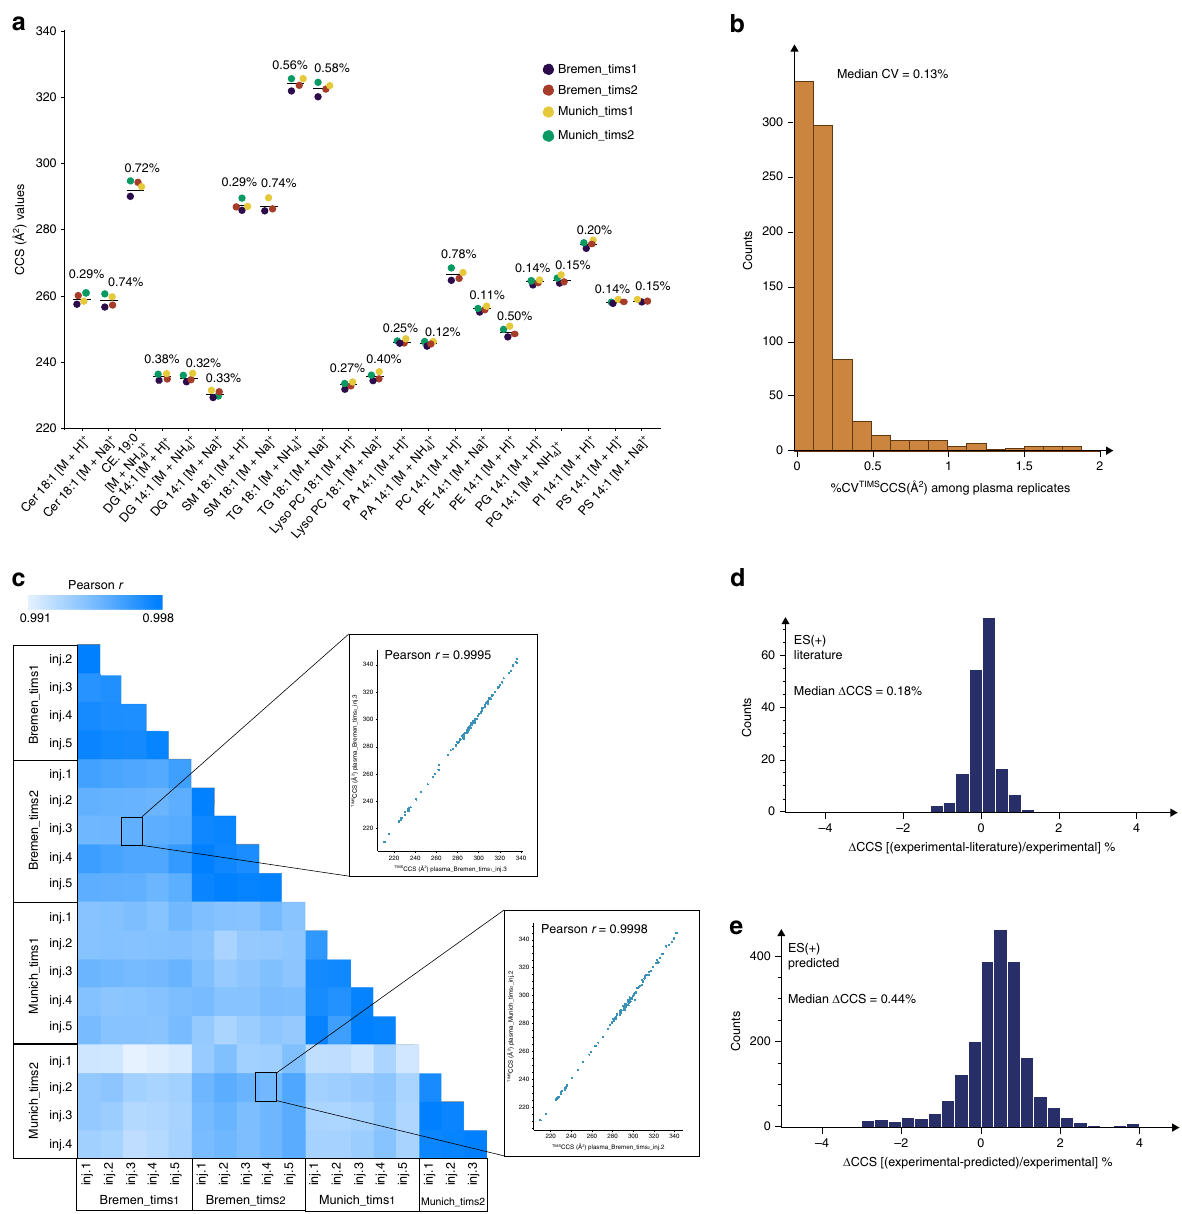
Fig. 5 Precise and accurate determination of lipid TIMS CCS values. a Cross-instrument and cross-laboratory TIMS CCS measurement of a mixture of standard compounds (source data provided in Supplementary Data 8). Data labels indicate the coef fi cient of variation (CV) ( n = 4 instruments). b CVs of TIMS CCS values for lipids commonly identi fi ed in replicate injections of a human plasma sample ( n = 5 replicates, n = 1 instrument). c Pair-wise correlation of lipid TIMS CCS values from human plasma SRM 1950 measured on four different timsTOF Pro instruments. Relative deviation of experimental TIMS CCS values in this study ( d ) from literature reports 23,24 and e machine learning predictions 24